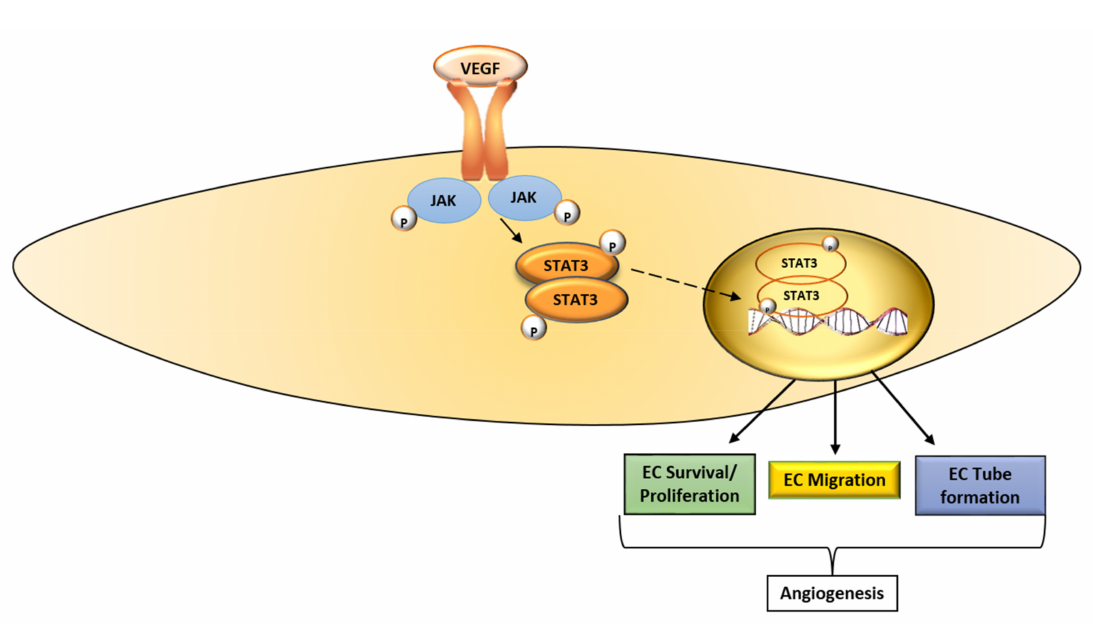
Figure 2. Schematic diagram of the VEGF-STAT3 signaling pathway. The binding of VEGF to VEGFR-2 activates JAK, which in turn phosphorylates STAT3. STAT3 is translocated to the nucleus where it promotes the transcription of molecules that promote endothelial cell proliferation, migration and tube formation, key EC functions that underlie angiogenesis. VEGF, vascular endothelial growth factor; JAK, Janus kinase; STAT3, signaling transducer and activator of transcription 3; EC, endothelial cell; → , activate; , translocate into the